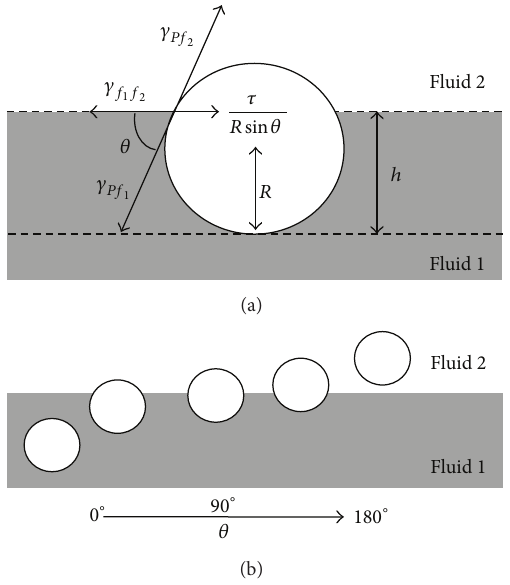
Figure 1: (a) Sketch of the contact angle, 𝜃 , for a particle at a fluid is the interfacial tension particle-bottom fluid, 𝛾 𝑃𝑓 the interface. 𝛾 𝑃𝑓 1 2 the interfacial tension interfacial tension particle-upper phase, 𝛾 𝑓 1 𝑓 2 fluid-fluid, and 𝜏 the line tension associated with the contact line of the particle with the interface. (b) Sketch of the position of a particle, with increasing hydrophobicity at the interface. Reproduced from [2], Copyright 2014, with permission from